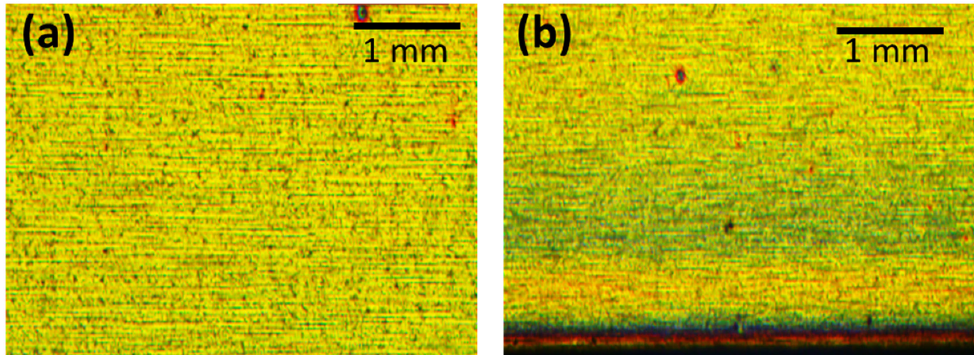
Figure 3. Typical optical micrographs of a 5 cm ink ‐ jetted SDP ‐ Y 2 O 3 film. The sample was printed at a tape speed of 35 m/h and pyrolyzed at a heating ramp of 3.7 °C /min up to 500 °C ( a ) Central part and ( b ) Edge of the SDP ‐ Y 2 O 3 film.